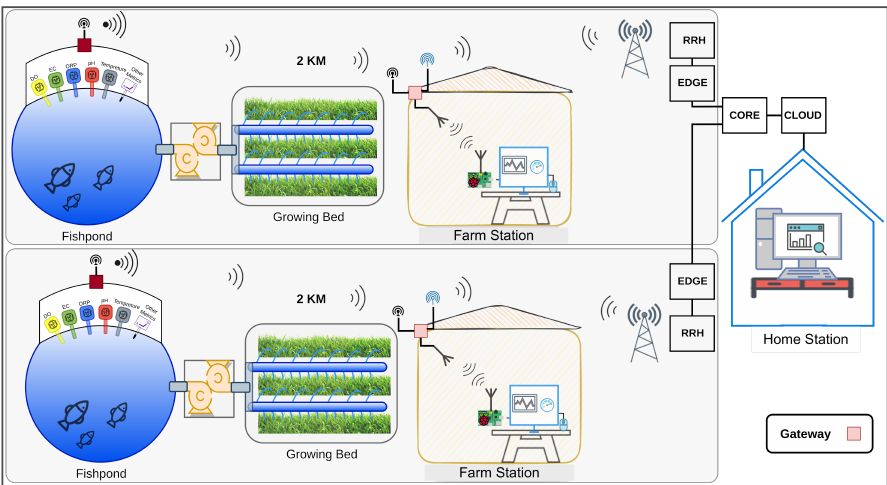
Figure 3. Proposed architecture for our Aquaponics Monitoring